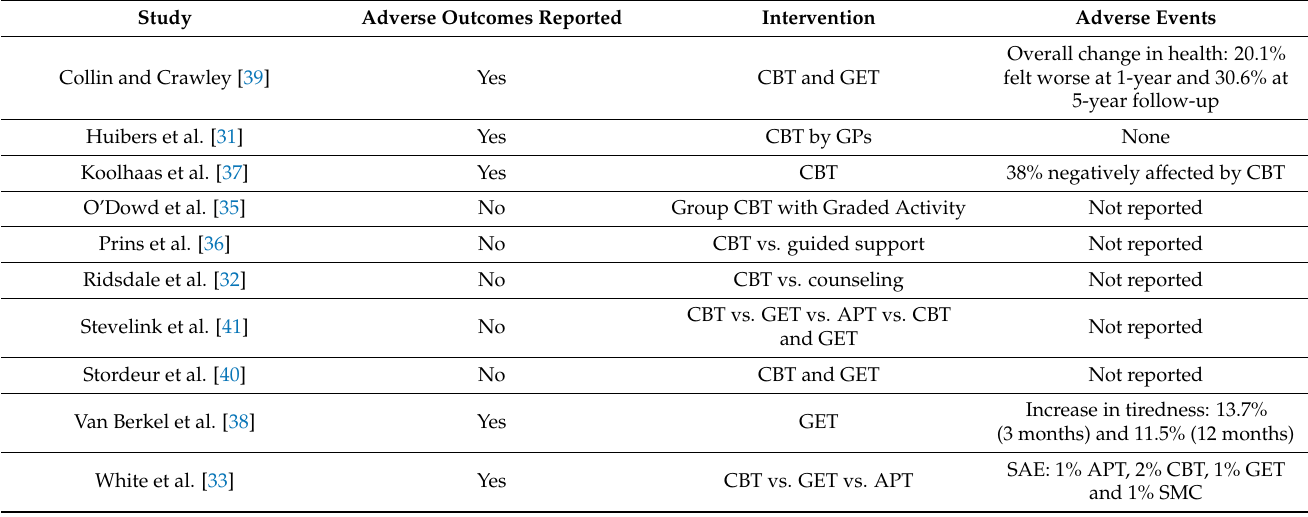
Table 2. Reporting of adverse